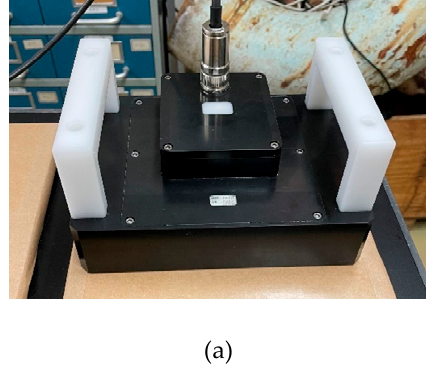
Figure 10. ( a ) 100-mm 2 sensor probe; ( b ) ELECT measurement system.